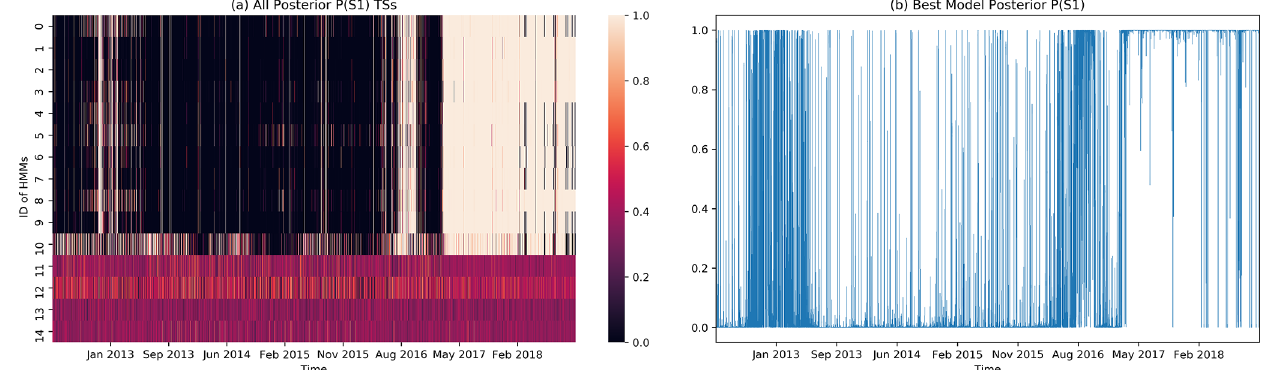
Figure 4. The step-by-step data visualization for CHCH. (a) A heatmap of the 15 HMMs’ posterior probability TSs for S 1 , sorted by model score from highest to lowest. The posterior probabilities for the last 4 HMMs are messy because the BWA estimations do not converge;